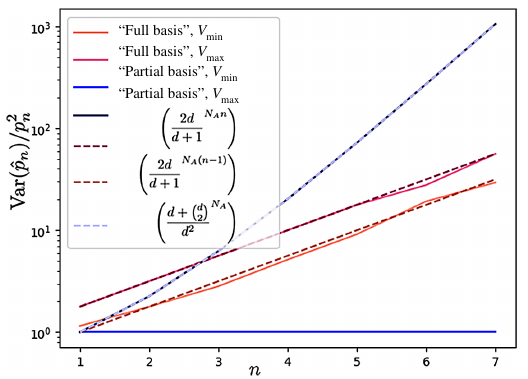
FIG. 5. Maximal and minimal variances for a two-qubit sys- tem using the full-basis and partial-basis methods, as obtained by a gradient-descent optimization. The results obtained for the maximally and minimally mixed states in Eqs. (42), (43), and (48) are presented with dashed lines for